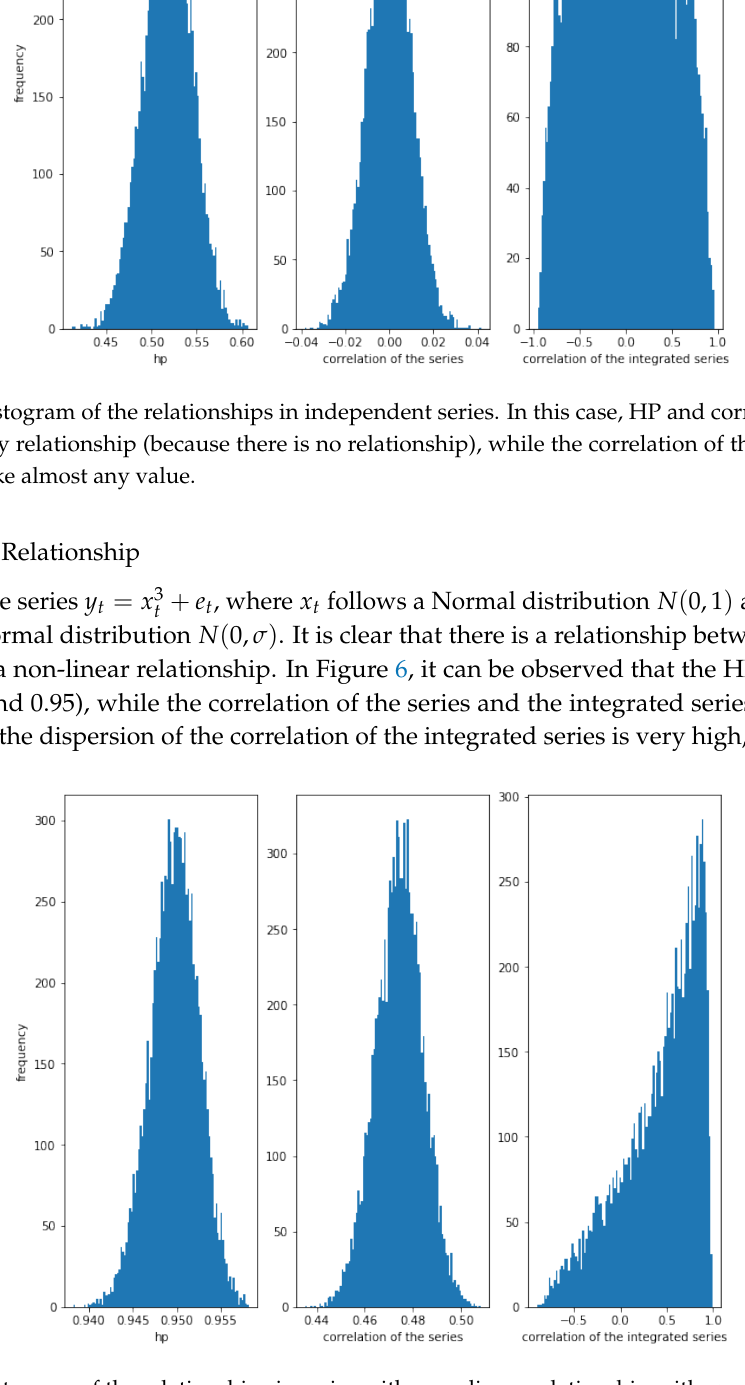
Figure 6. Histogram of the relationships in series with a nonlinear relationship with σ = 5. While HP is very high, correlation is weak and the correlation of the integrated series is often high, but there is a lot of